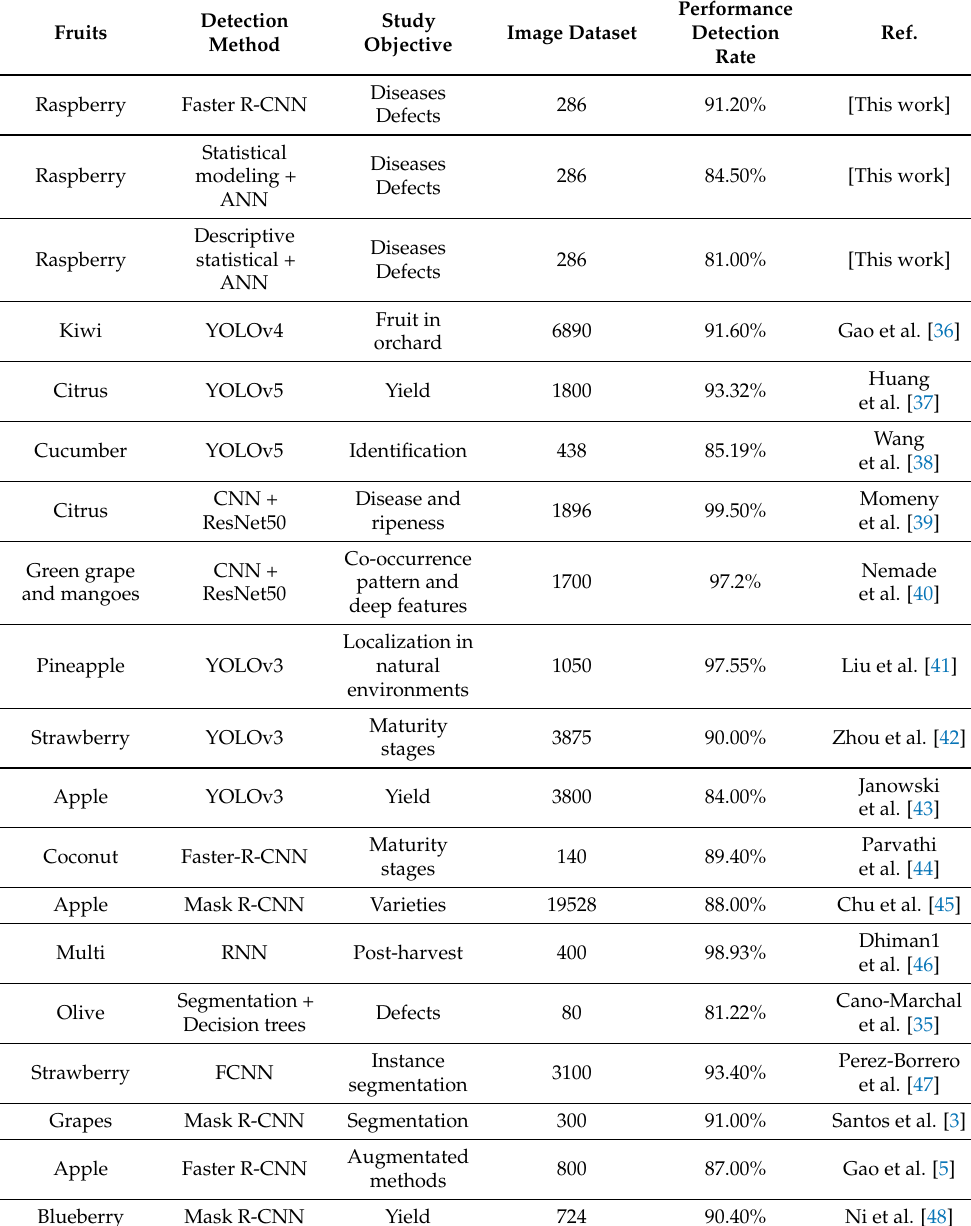
Table 5. Summary of some works related to studies on fruit-based quality detection. Note that CNNs predominate in DL